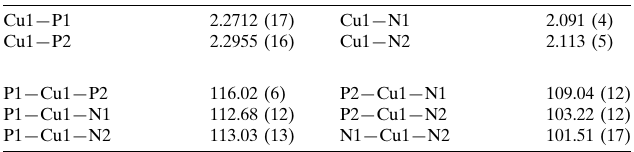
Selected geometric parameters (A˚ , (cid:3) ).